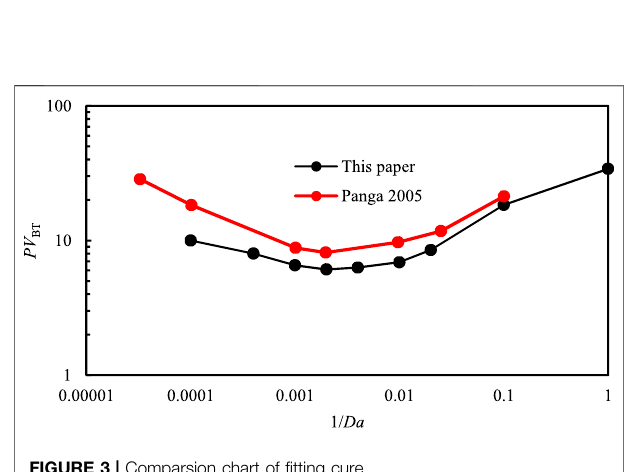
FIGURE 3 | Comparsion chart of fi tting cure.